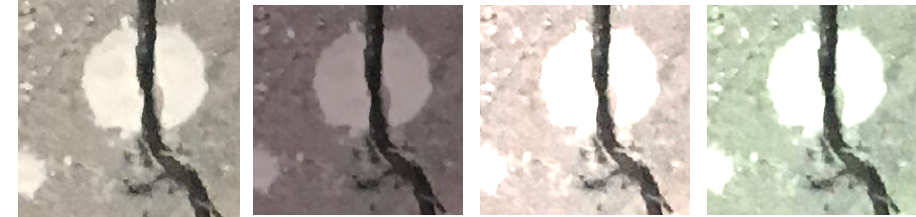
Figure 5. Example of Color Jitter transformation. (Left is the original image).